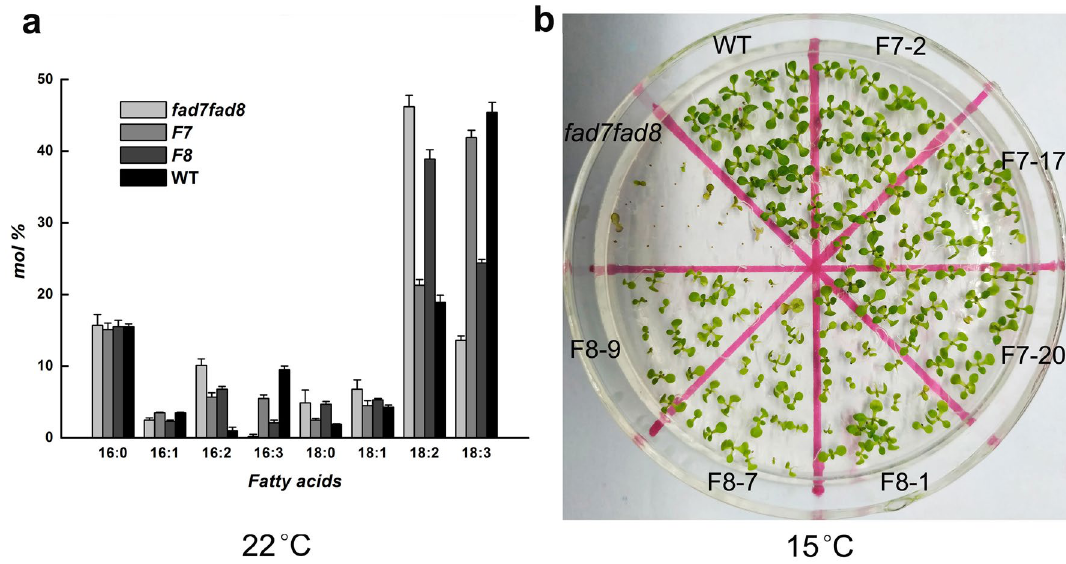
Figure 2. Functionality of CbFAD7 and CbFAD8 were verified in Arabidopsis mutant. ( a ) Comparison of total leaf fatty acids between Arabidopsis lines under normal conditions. ( b ) Comparison of low-temperature germination between Arabidopsis lines. WT means wild type (Col-0); fad7fad8 means double fad7fad8 mutant; F7 means CbFAD7 -complemented mutant; F8 means CbFAD8 -complemented mutant. Each value represents the mean ± SE of five